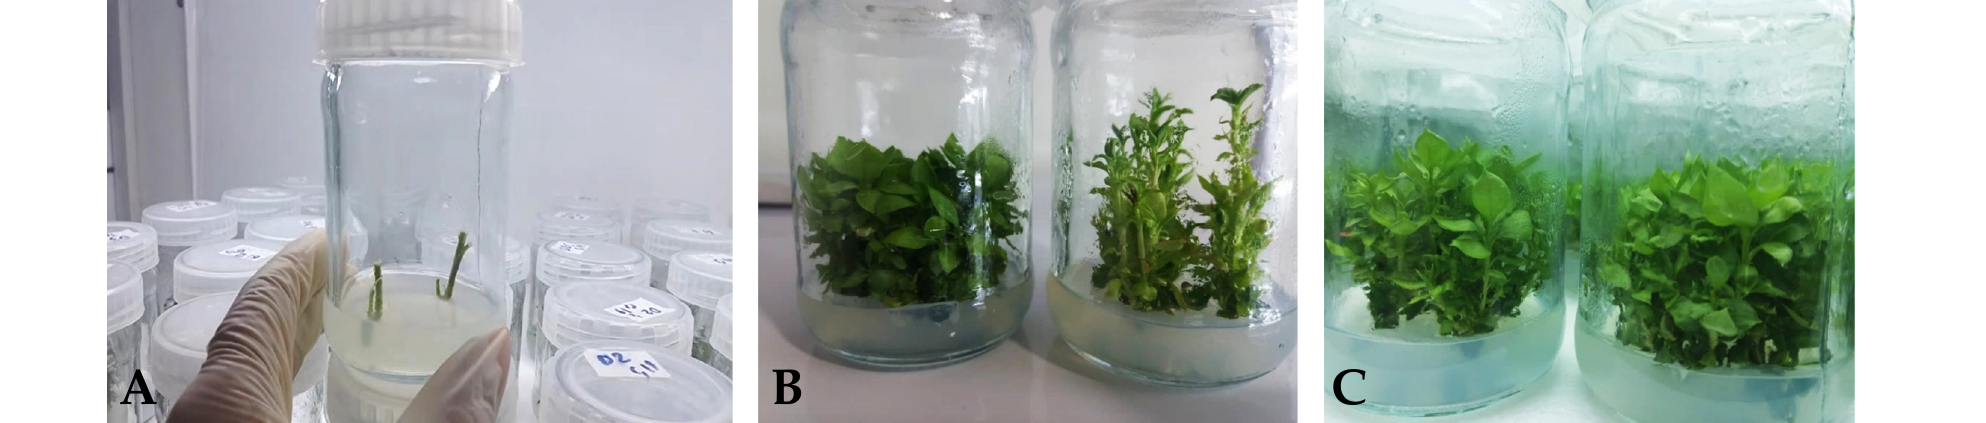
Figure 1. In vitro propagation of pear ( Pyrus communis L.) ‘Pyrodwarf ® (S)’ rootstock. ( A ) Nodal segments containing two lateral buds used as primary explants, ( B ) Microshoots produced in the MS medium enriched with 2 mg·L –1 BA together with 1 mg·L –1 Kin, after 30–35 days (left jar), and microshoots produced in the WPM medium with 2 mg·L –1 BA and 1 mg·L –1 Kin (right jar), ( C ) Microshoots produced in the MS medium enriched with 2 mg·L –1 BA together with 1 mg·L –1 Kin, after 30–35 days of the second sub-culture (left and right jars).